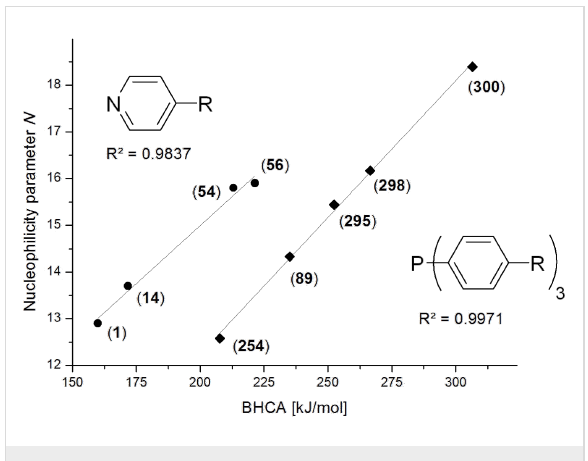
Figure 8: Comparison of BHCA values (kJ/mol) and nucleophilicity parameters N for sterically unbiased pyridines and phosphanes.